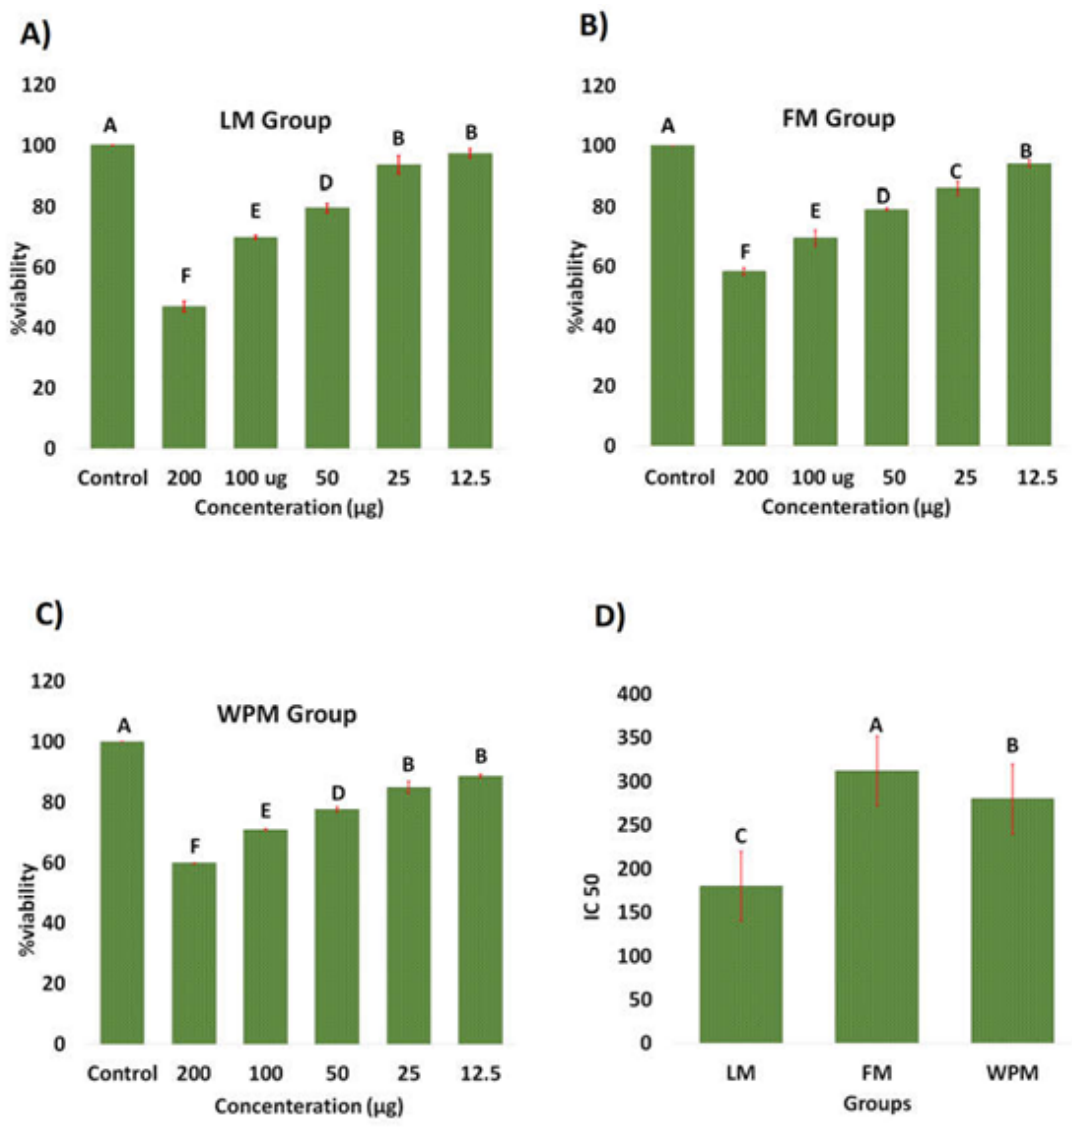
Figure 3. Effect of; ( A ) leaf extract, ( B ) flower extract, and ( C ) whole plant extract on the viability of HepG2 cells line and ( D ) their cytotoxicity IC50 values. The different alphabet at chart bars showing significant difference.